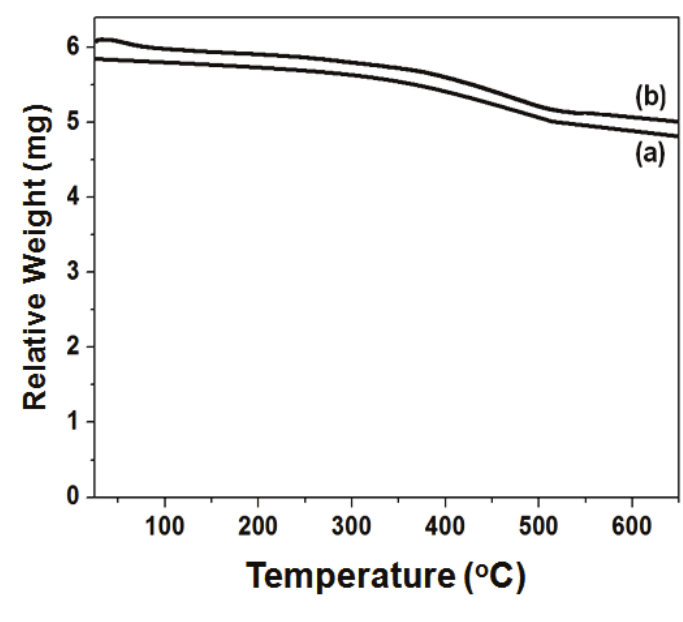
Figure 6. TG analysis of LiCoPO ( b ) C H CoO 4H O as starting 4 6 4 2